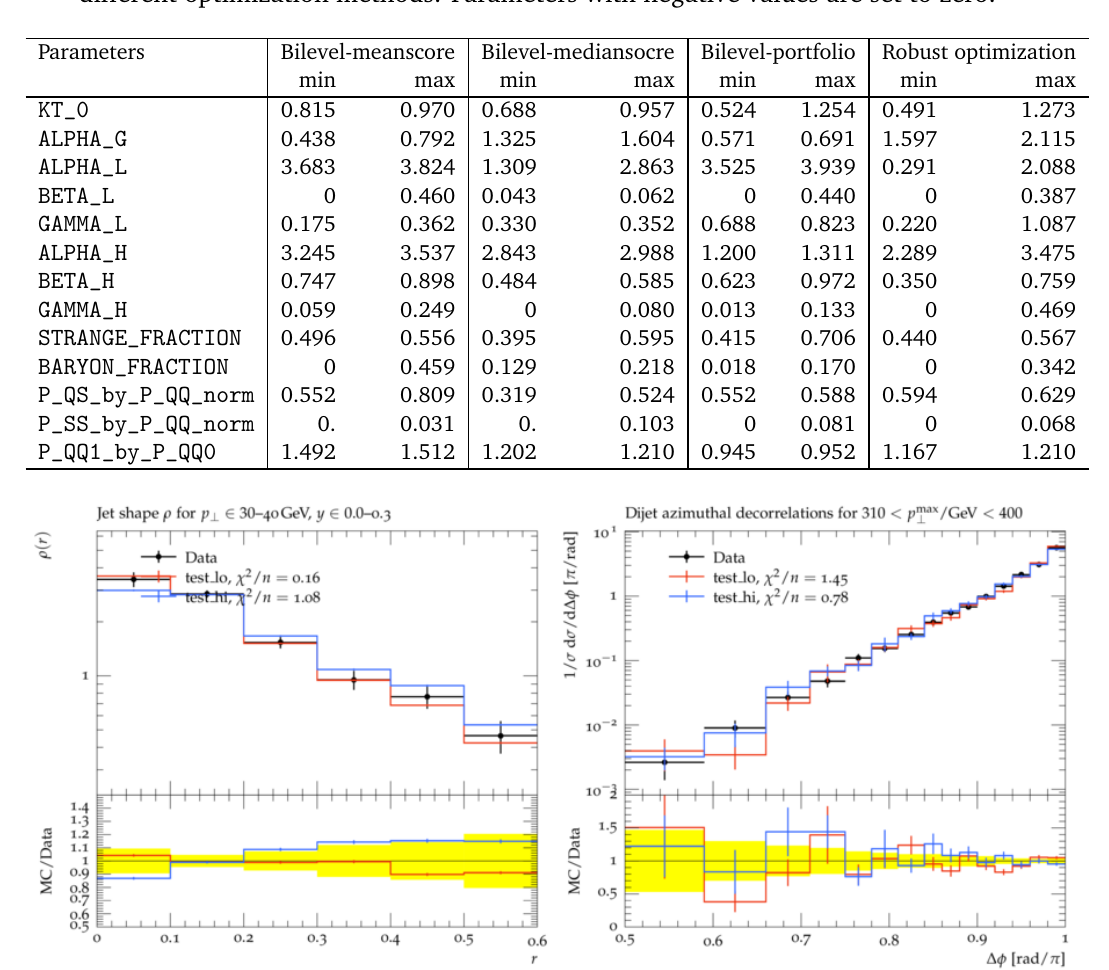
Table 14: Eigentune results for the S HERPA data using the rational approximation for different optimization methods. Parameters with negative values are set to zero.